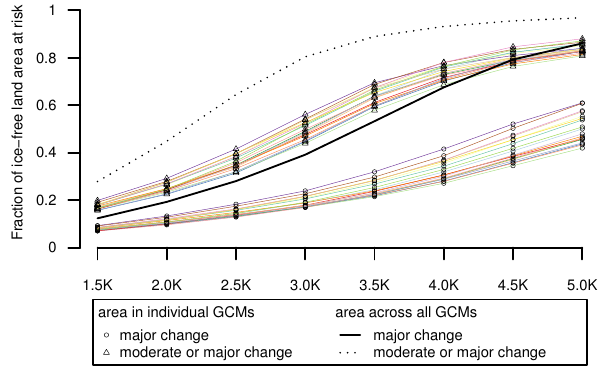
Fig. 5. Importance of climate ensemble analysis. Circles and trian- gles denote the area projected at risk of major or at least moderate change, respectively, by individual AOGCMs. The black solid and dashed lines mark the total area at risk across all AOGCMs. Higher total areas result from regional differences between